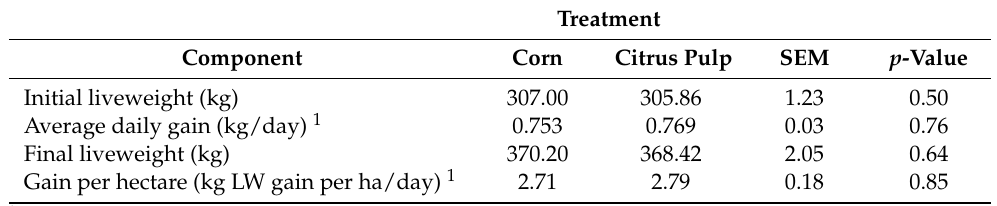
Table 6. Liveweight performance of Nellore bulls fed corn or citrus pulp-based supplements and beef produced per area in Uruchloa brizantha cv Marandu pastures during the wet-dry transition period. Treatment Component Corn Citrus Pulp SEM p -Value Initial liveweight (kg) 307.00 305.86 1.23